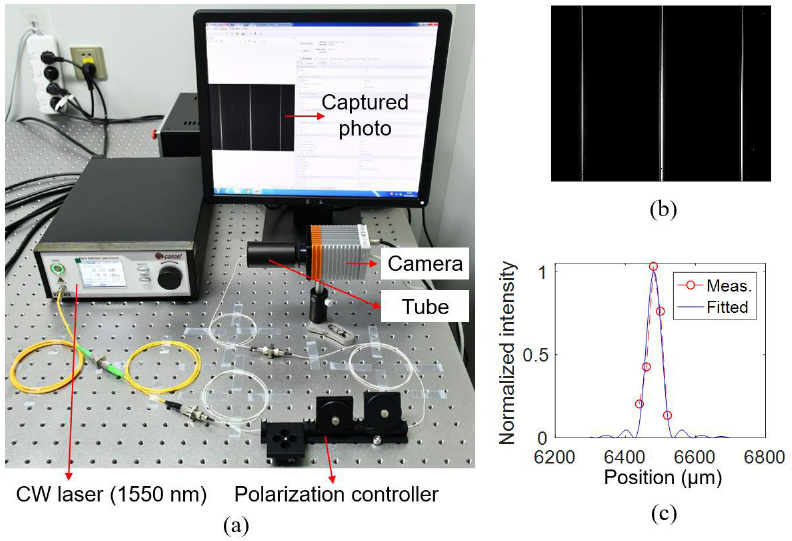
Figure 17. ( a ) Experimental setup for testing the WSL chip mounted to the camera. ( b ) Spectral lines at 1550 nm. ( c ) Measured and fitted far-field distributions with an FWHM of 0.73 nm at 1550 nm.